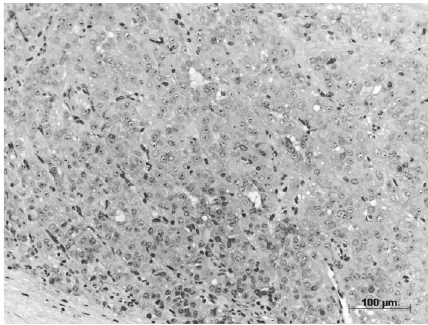
Figure 2: Small round cells in nests of clusters and intervening cap- illaries, typical for Leydig cell tumors (Hematoxylin-Eosin staining,